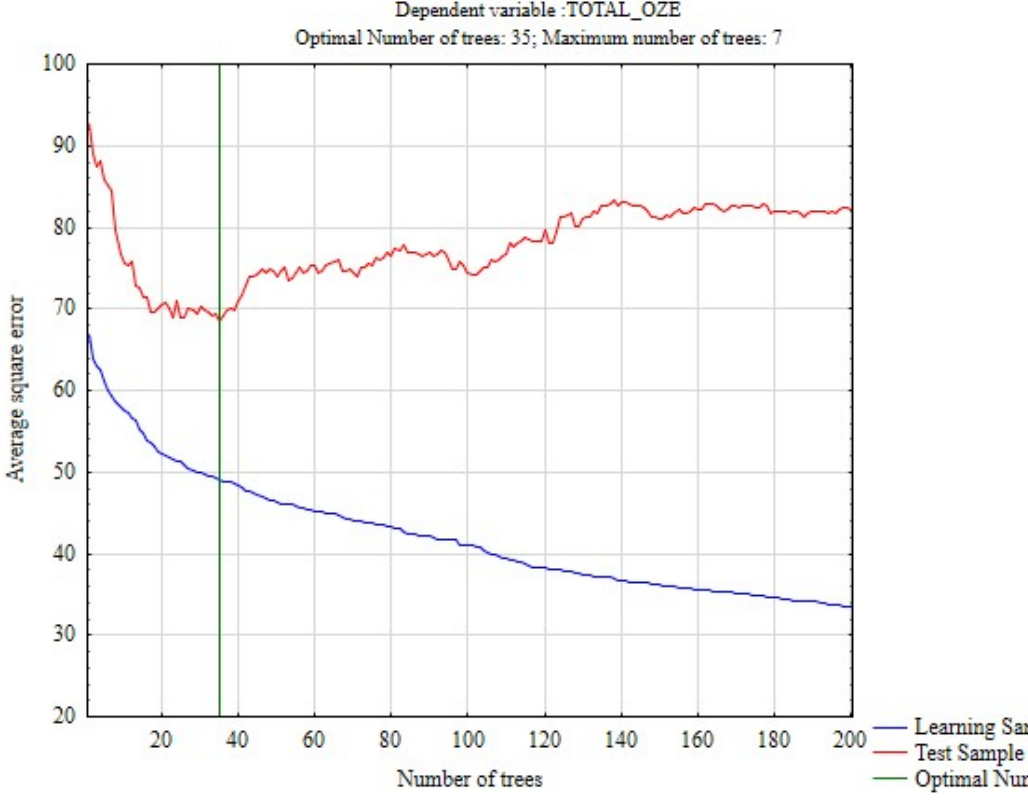
Figure 2. Determining the optimum number of trees.